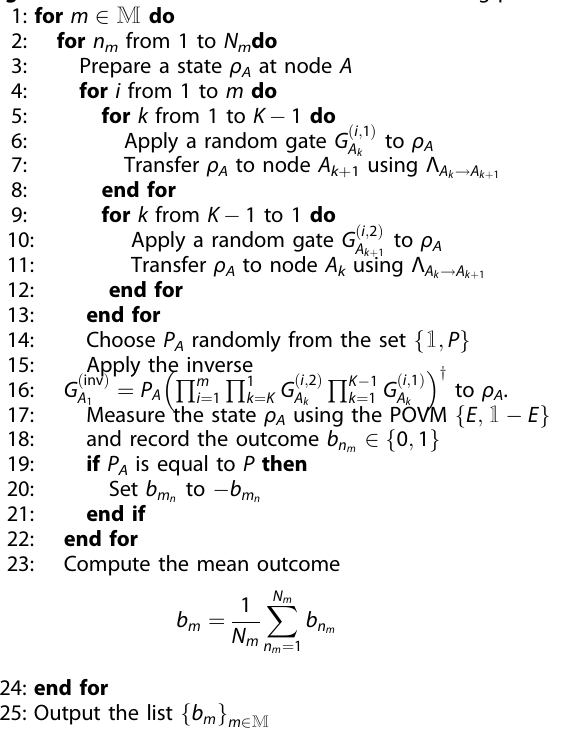
Algorithm 2 . The multi-node network benchmarking protocol 1: for m 2 M